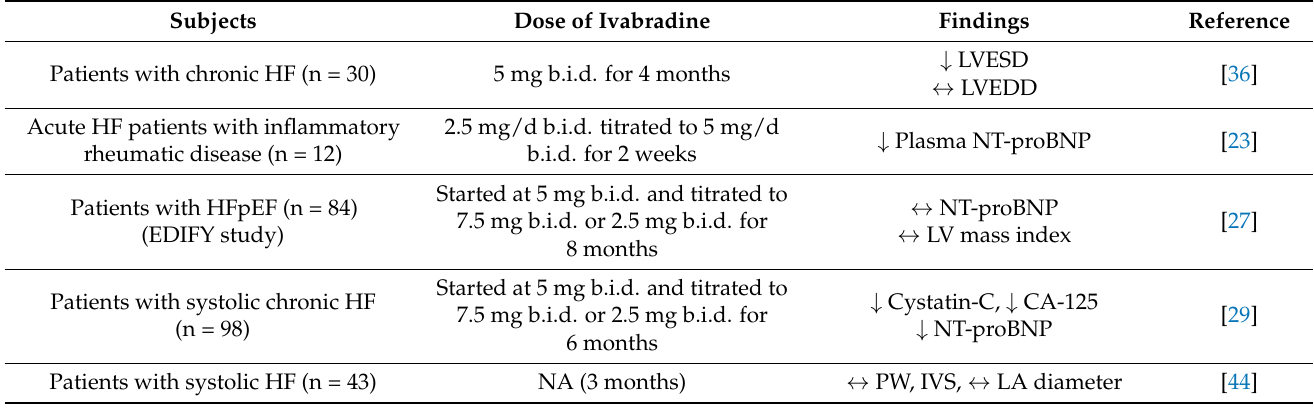
Table 8. Effects of ivabradine on cardiac structure and hypertrophy in patients with heart failure and animal